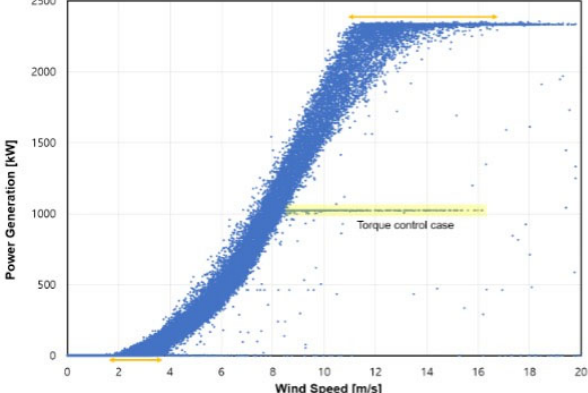
Figure 4. Actual wind power curve for 3 MW generation in Yeonggwang Baeksu wind farm.